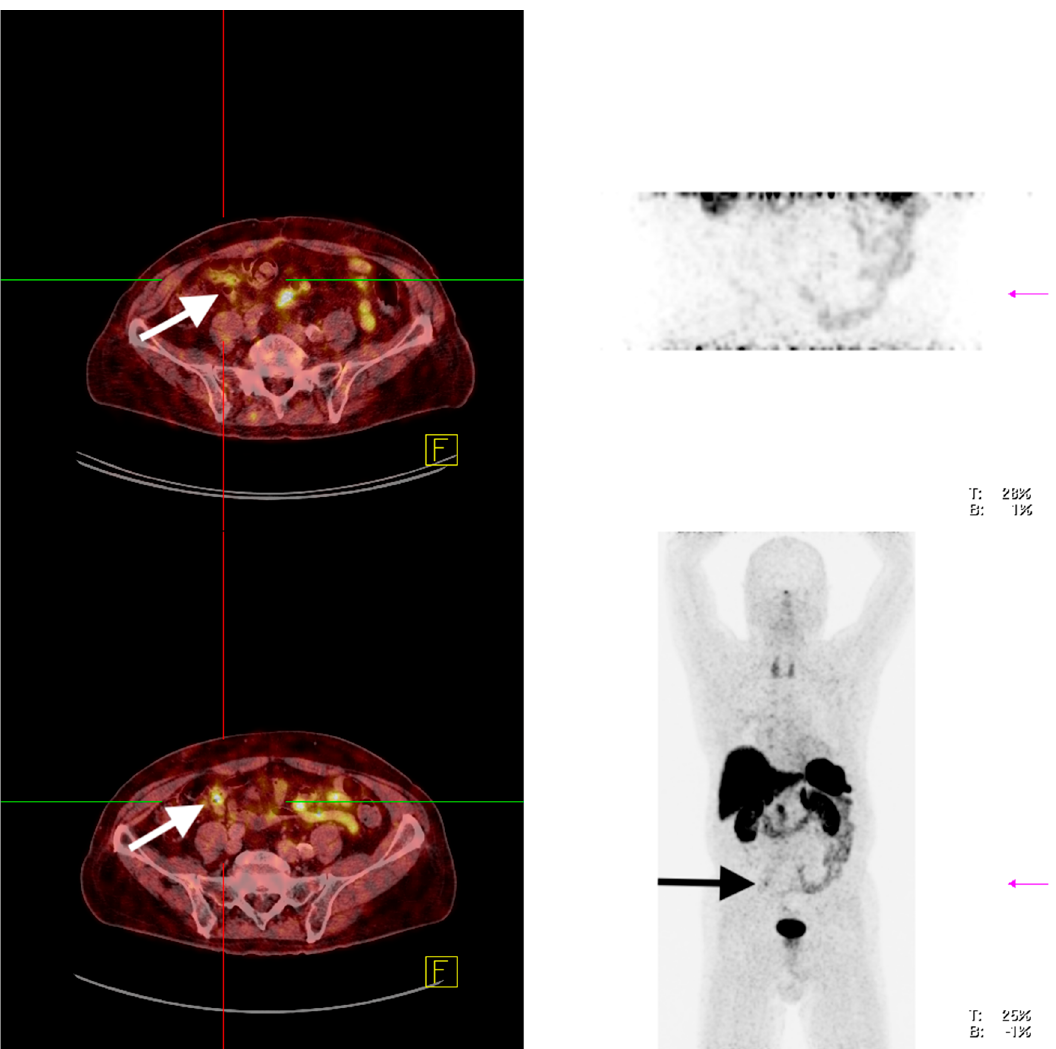
Table 5. Sensitivity and specificity of 68 Ga-DOTATOC-PET/CT A2 with histologic confirmation. Sensitivity = 71.4% Specificity = 75.0%